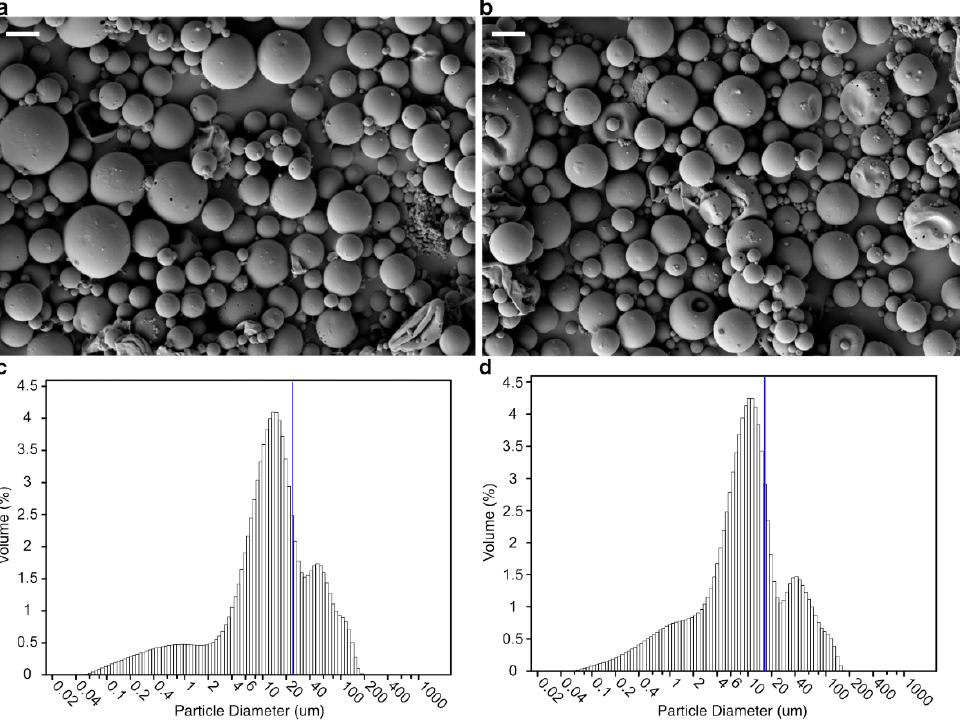
Figure 1. Morphological characteristics of the microsphere. Scanning electron microscope (SEM) images of the bacteriophage-loaded polylactic-co-glycolic acid (PLGA) microsphere ( a ), and PLGA/alginate-composite microsphere ( b ). Scale bar, 10 µ m. Size distribution of the bacteriophage- loaded PLGA microsphere ( c ), and PLGA/alginate-composite microsphere ( d ). The blue line repre- sents mean size of the